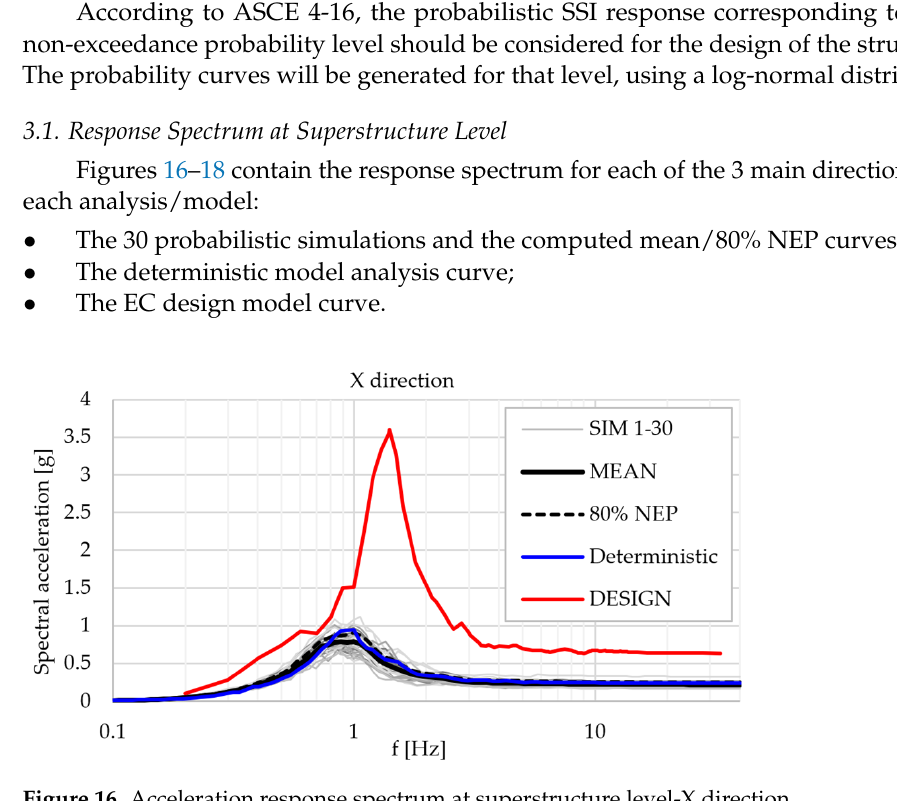
Figure 16. Acceleration response spectrum at superstructure level-X direction.